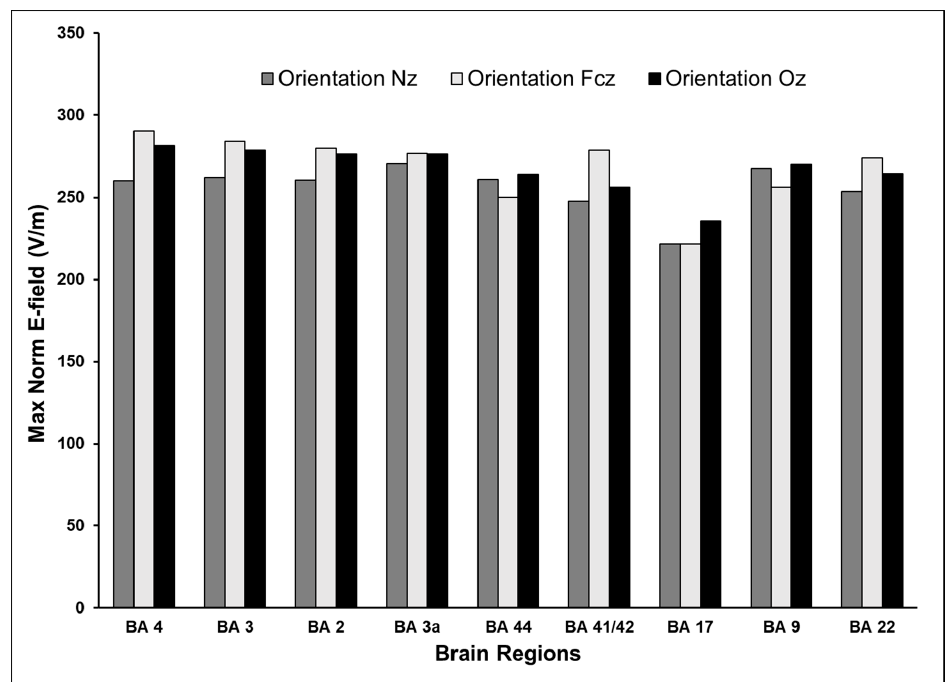
Figure 7. Effect of TMS coil direction on maximum norm E-field. Coil orientations examined were pointing to Nz, FCz, or Oz electrodes on the 10-10 EEG system. The TMS intensity modeled was dI/dt = 150 A/µs. The change in coil orientation had the most impact on the maximum norm E-field for coil at positions BA4 and BA 41/42 while a minimal impact at BA 3a.